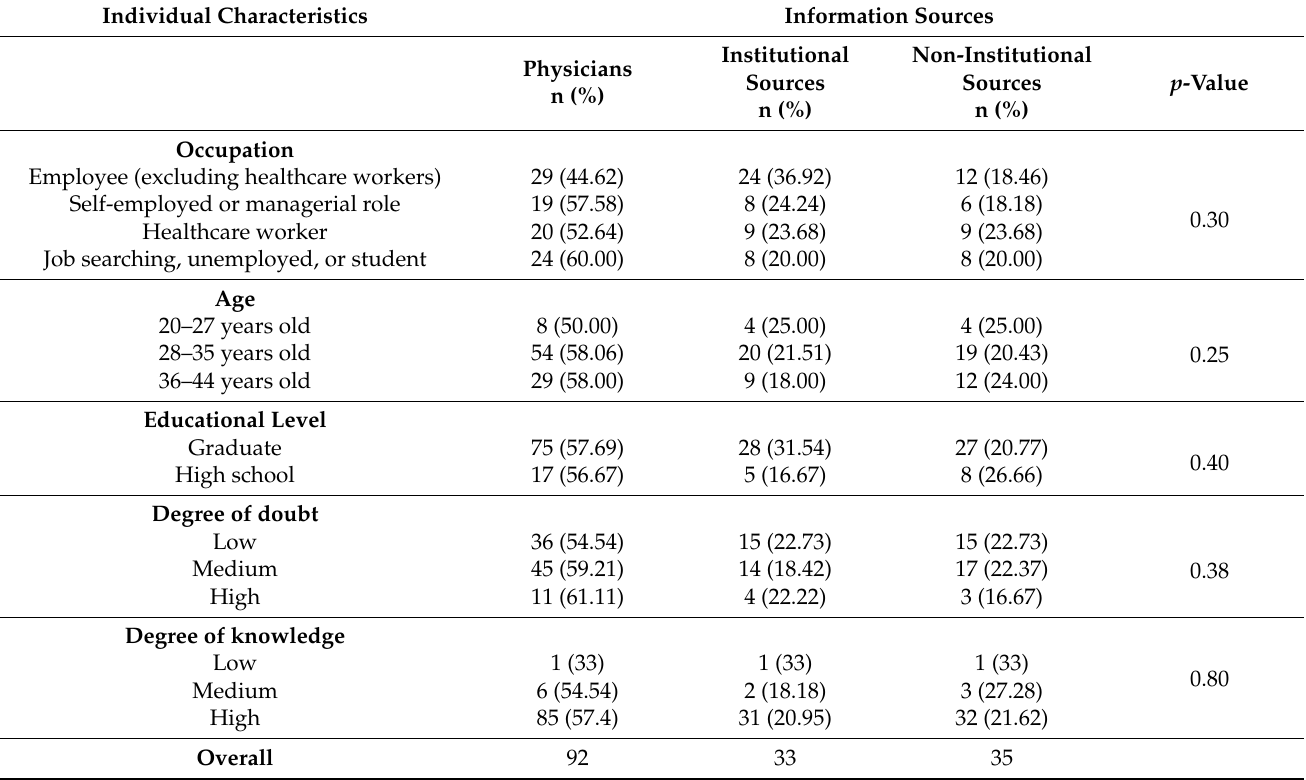
Table 6. Information sources considered decisive for the vaccination choice (N =